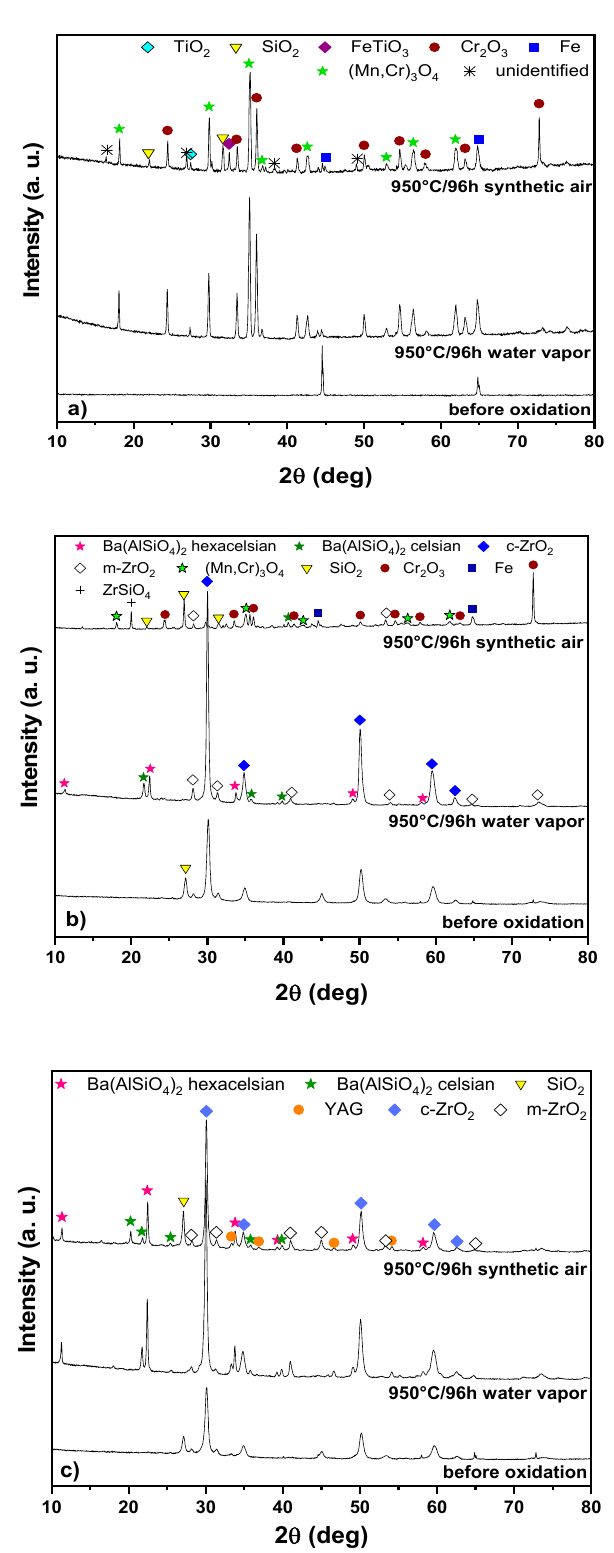
Figure 1. XRD diffraction patterns of tested materials before and after oxidation tests at temperature of 950 °C after 96 h exposure ( a ) steel, ( b ) C2c, ( c ) D4. The evaporation rate of Cr 2 O 3 is linearly dependent on the time of exposure in an oxidizing atmosphere, and higher temperatures lead to higher evaporation rates [36].